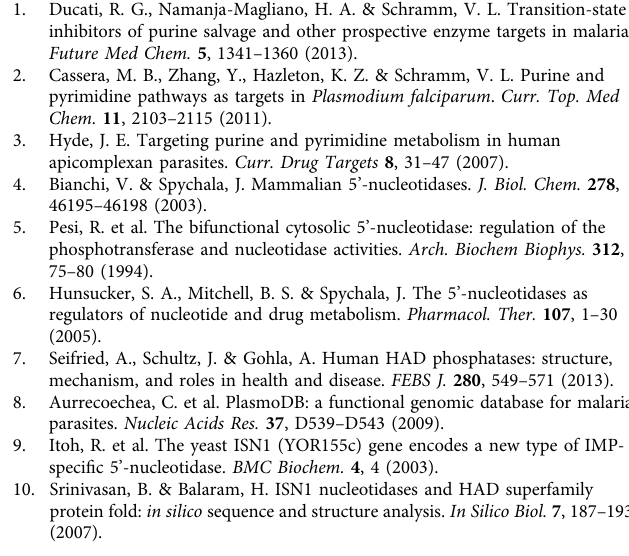
Figure rendering . Figures of three-dimensional structures were drawn with PyMol (DeLano Scienti fi c LLC, http://pymol.sourceforge.net/) and Chimera 39